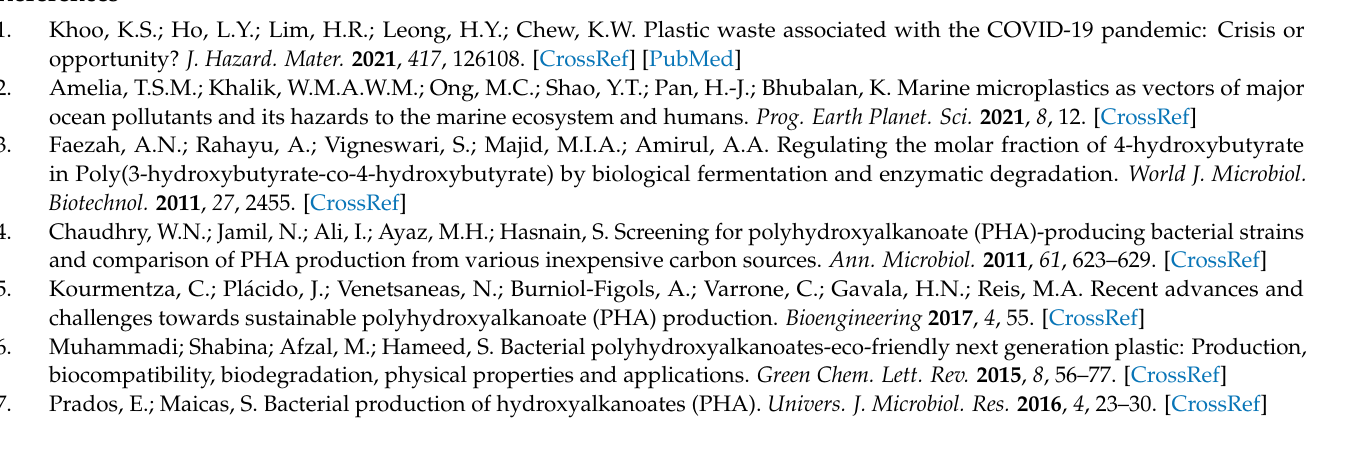
Figure S3: Workflow schematics from screening for PHA-producing strains using Nile blue, PHA production using shaken-flask fermentation, to PHA composition analysis using gas chromatography; Figure S4: Donut chart showing the relative abundance of classes detected in the bacterial diversity profiles of this study and another similar study accessible via the MG-RAST public repository for comparison [42,43]. Starting from the inner circle are the bacterial communities from (1) A. aaptos of Redang Is-land; (2) X. muta of Bidong Island; (3) A. aaptos of Bidong Island; (4) A. corrugata of Broward County; (5) A. corrugata of Fort Lauderdale; (6) A. corrugata of Summerland Key; Text S1: 16S rRNA sequence of Sphingobacterium mizutaii strain UMTKB-6; Text S2: 16S rRNA sequence of Alcaligenes faecalis subsp. faecalis strain UMTKB-7; Text S3: 16S rRNA sequence of Acinetobacter calcoaceticus strain UMTKB-8; Table S1: Retention times and peak areas of the detected monomers for Sphingobacterium mizutaii UMTKB-6, Alcaligenes faecalis UMTKB-7, and Acinetobacter calcoaceticus UMTKB-8; Table S2: Cell dry weight of Sphingobacterium mizutaii UMTKB-6, Alcaligenes faecalis UMTKB-7, and Acinetobacter calcoaceticus UMTKB-8.; Table S3: Primers 341F and 806R targeting 16S rRNA genes of regions V3 and V4